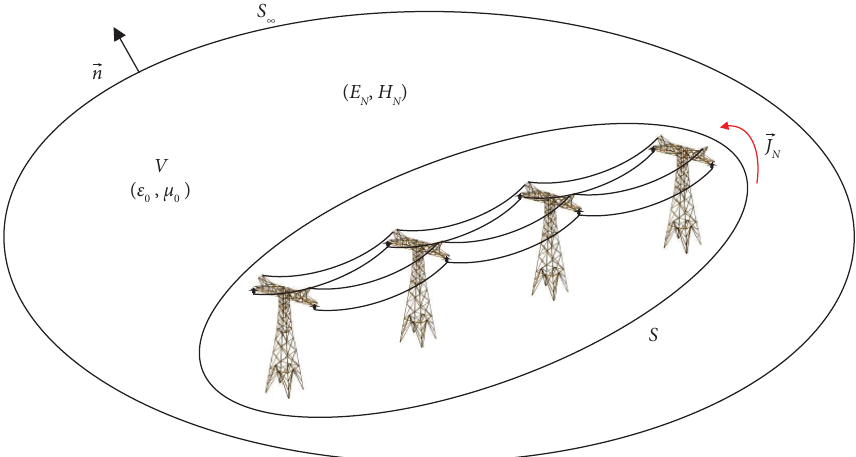
Figure 3: Schematic diagram of the N th-order characteristic mode current and feld for the